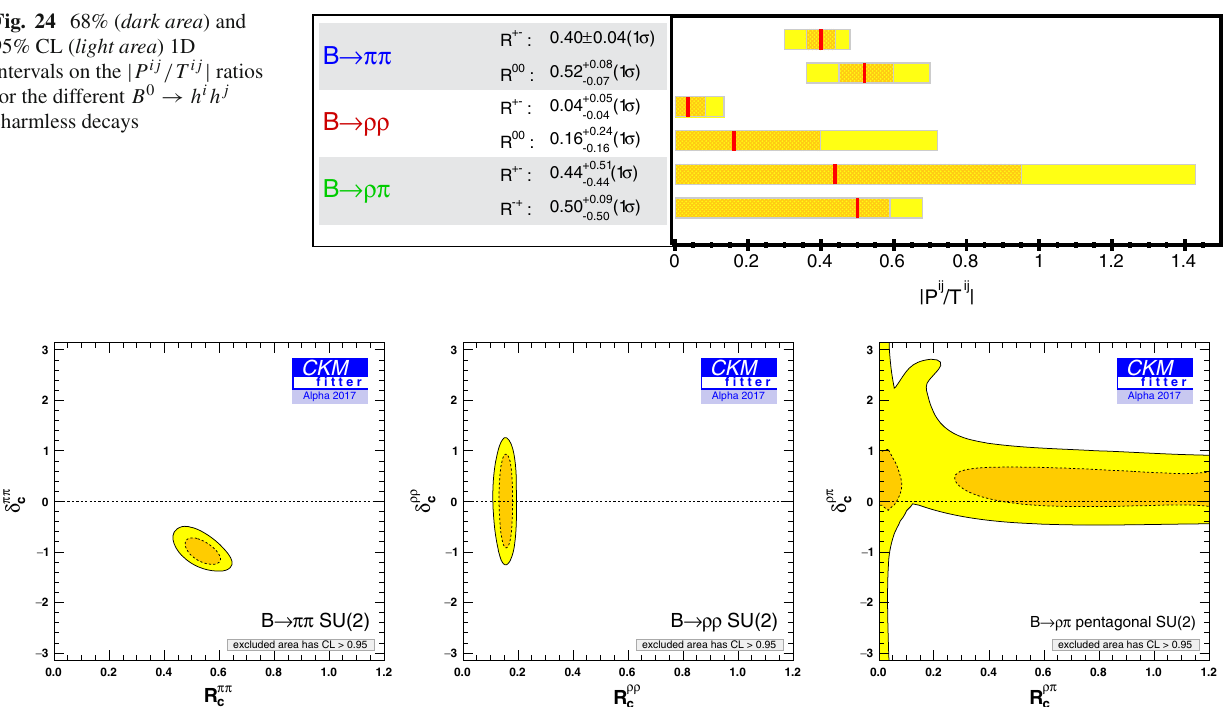
Fig. 25 Two-dimensional constraints on the modulus and phase of the colour-suppressed ratio T 00 / T +− = R c e i δ c for B → ππ ( left ), B → ρπ ( middle ) and B 0 → ρπ ( right )